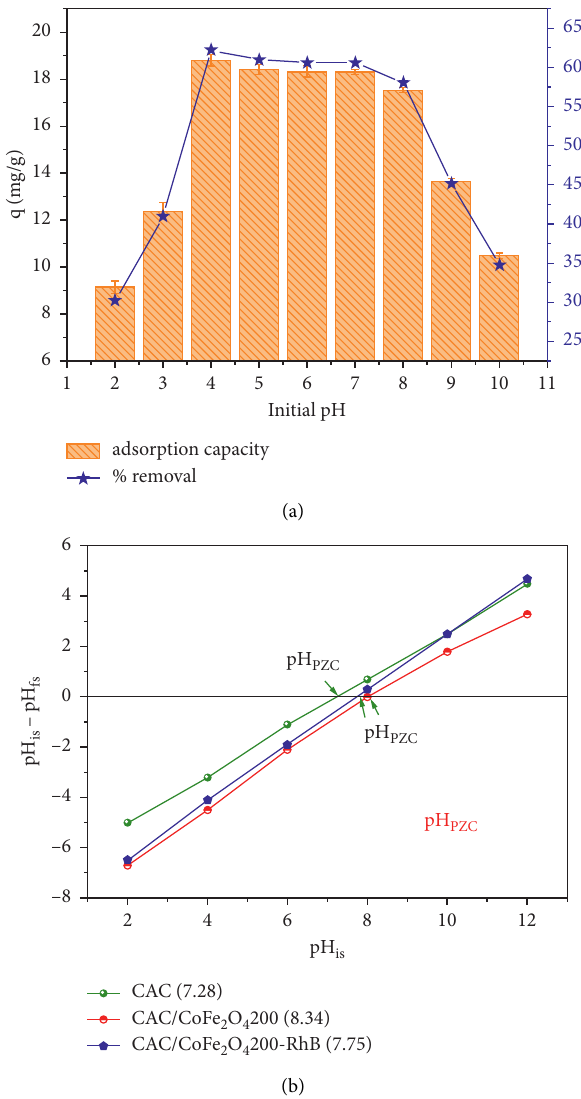
Figure 4: Effects of different pH levels on RhB adsorption by CAC/CoFe 2 O 4 200 at 50mg/L of initial RhB, 60 min of contact time, 0.05g CAC/CoFe 2 O 4 200/25mL RhB of adsorbent dosage (a), and pH PZC of CAC/CoFe 2 O 4 200